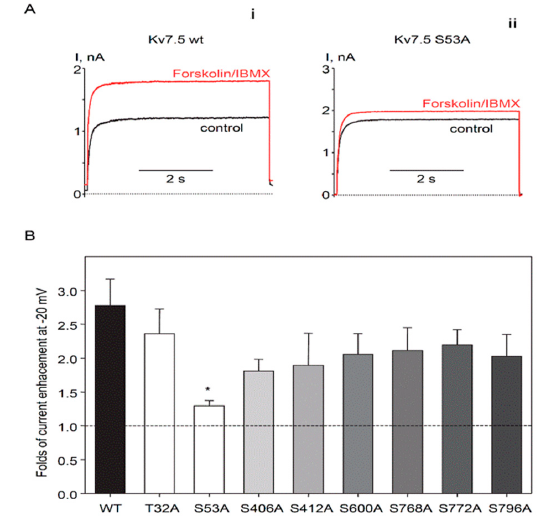
Figure 3. Putative PKA phosphorylation site Ser53, on the N-terminus of the Kv7.5 channels, is required for enhancement of Kv7.5 currents by forskolin/IBMX. ( A ) Representative traces of current through exogenous wild-type Kv7.5 channels (i) and through Kv7.5 S53A mutant channels (ii) recorded at − 20 mV before (black, C = 14.2 pF) and after (red, C = 28.8 pF) application of forskolin (10 µ M) in combination with IBMX (500 µ M) for 5 min. ( B ) Relative forskolin/IBMX-induced enhancement of the